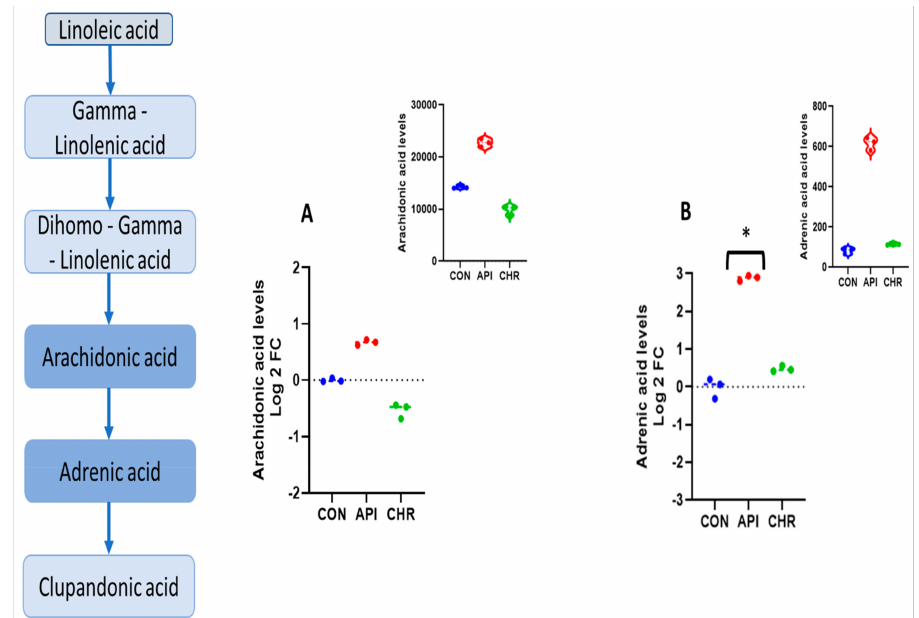
Figure 5. Metabolites of the linoleic acid pathway regulated by apigenin. In the linoleic acid pathway, the metabolites that were differentially regulated by apigenin were: ( A ) arachidonic acid, and ( B ) adrenic acid. The upper inserts represent the raw values. The log2 fold change values were plotted using GraphPad and significance set at * p < 0.05 with a +/ − 1.5 fold